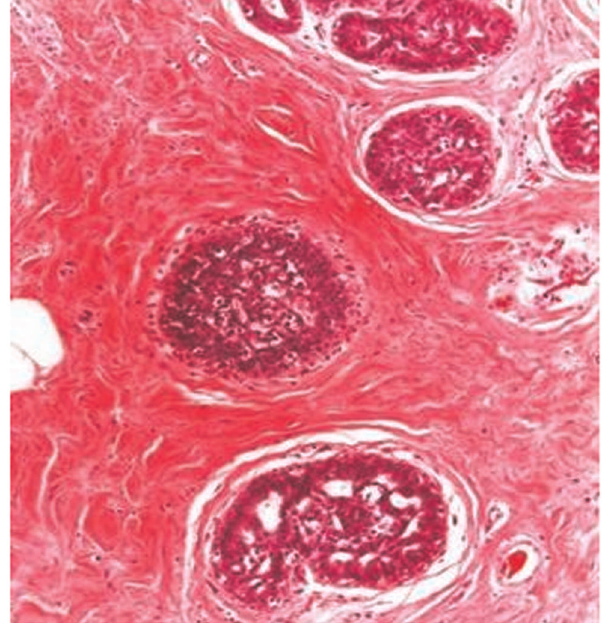
Figure 1 - (A) and (B) Well-circumscribed mass with normal terminal ductal lobuler unit, fat and hyalinized stroma, Hematoksilen Eosin (H&E), 6